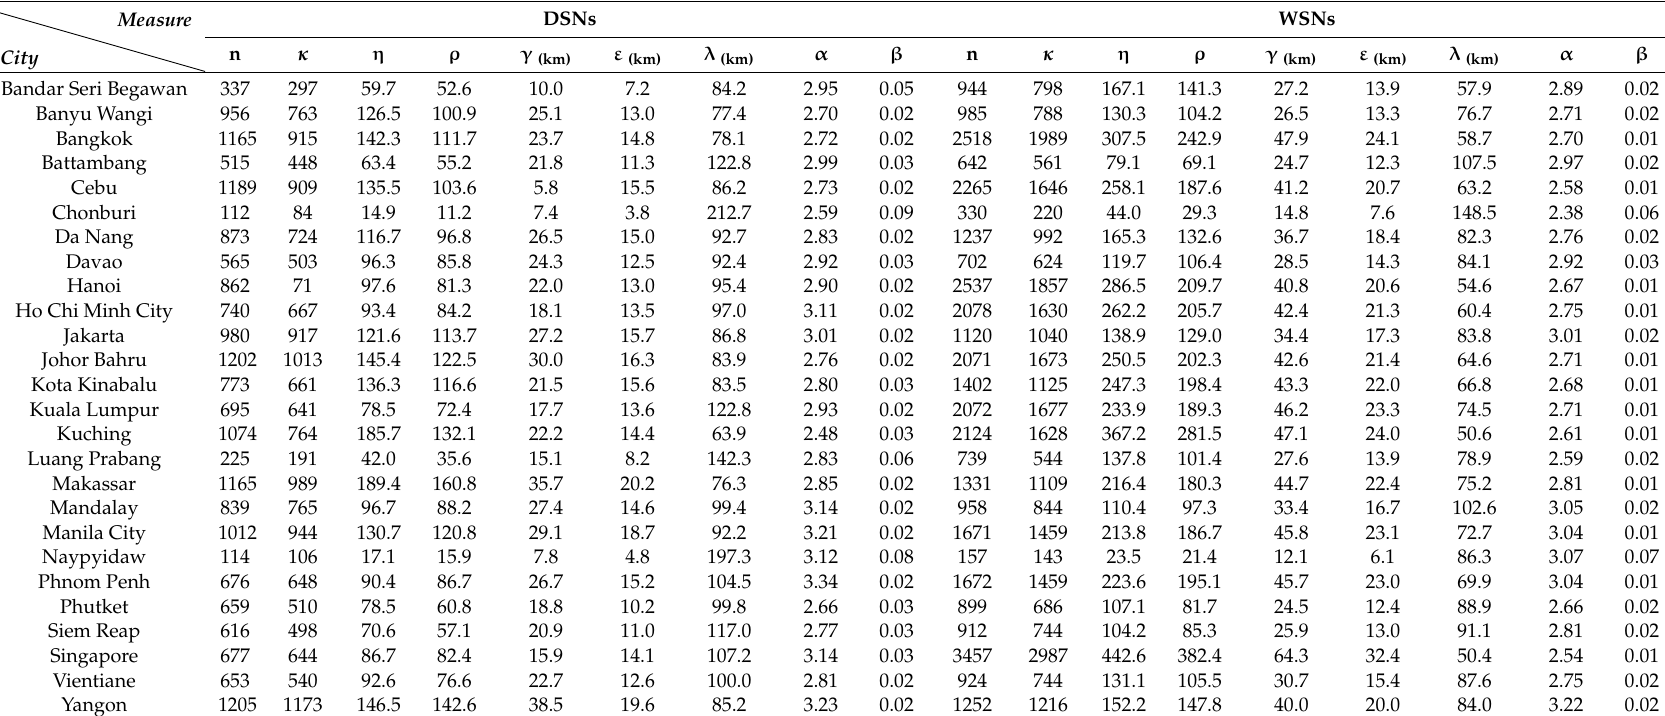
Table 4. The measures of two types of SNs in 26 pilot